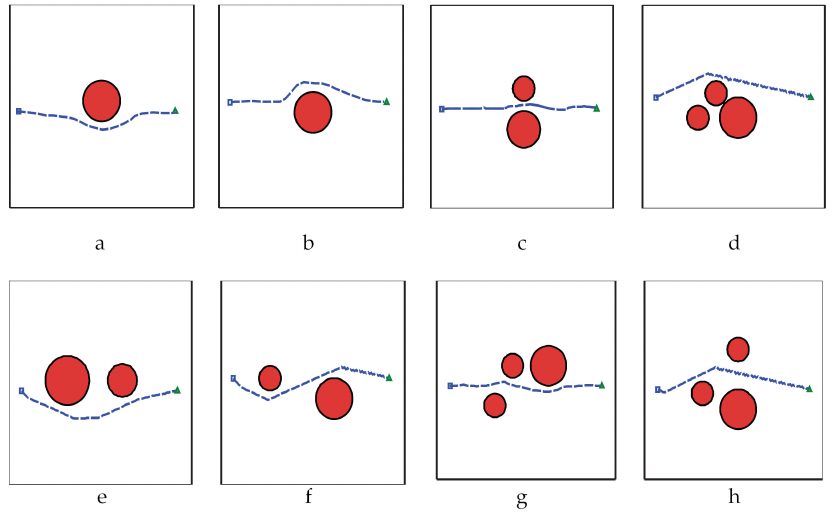
Figure 14. Neural network training data. ( a – h ) Generated paths with single and multiple obstacles with different placements during training phase [324].